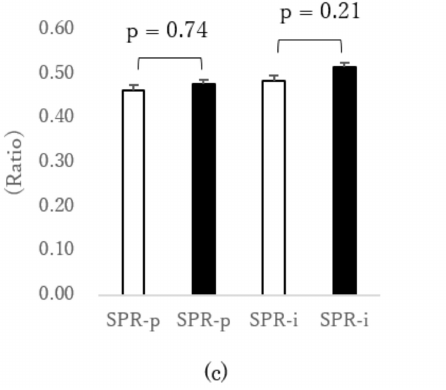
Figure 3. Comparison of external force under the fifth MTH due to differences in shoe width ( (cid:3) fit width vs. (cid:4) narrow width). ( a ) Peak normal stress (pressure) (PP) and peak shear stress (PSS), ( b ) normal stress (pressure) time integral (PI) and shear stress time integral (SSI), and ( c ) shear stress/normal stress (pressure) ratio of peak value (SPR-p) and shear stress/normal stress (pressure) ratio of time integral value (SPR-i). * p < 0.05 paired t -test. Error bar was standard error (SEM). MTH: metatarsal head. The difference between the participants’ foot width and shoe width was seven mm on average in case of shoes of fit width, in which shoes were wider than feet. In contrast, the average of the difference was − 3 mm for narrow shoes, in which shoes were narrower than feet. The correlation coefficient between the difference of width (shoes versus feet) and the PSS was − 0.26, which was only a weak negative correlation (Figure 4).